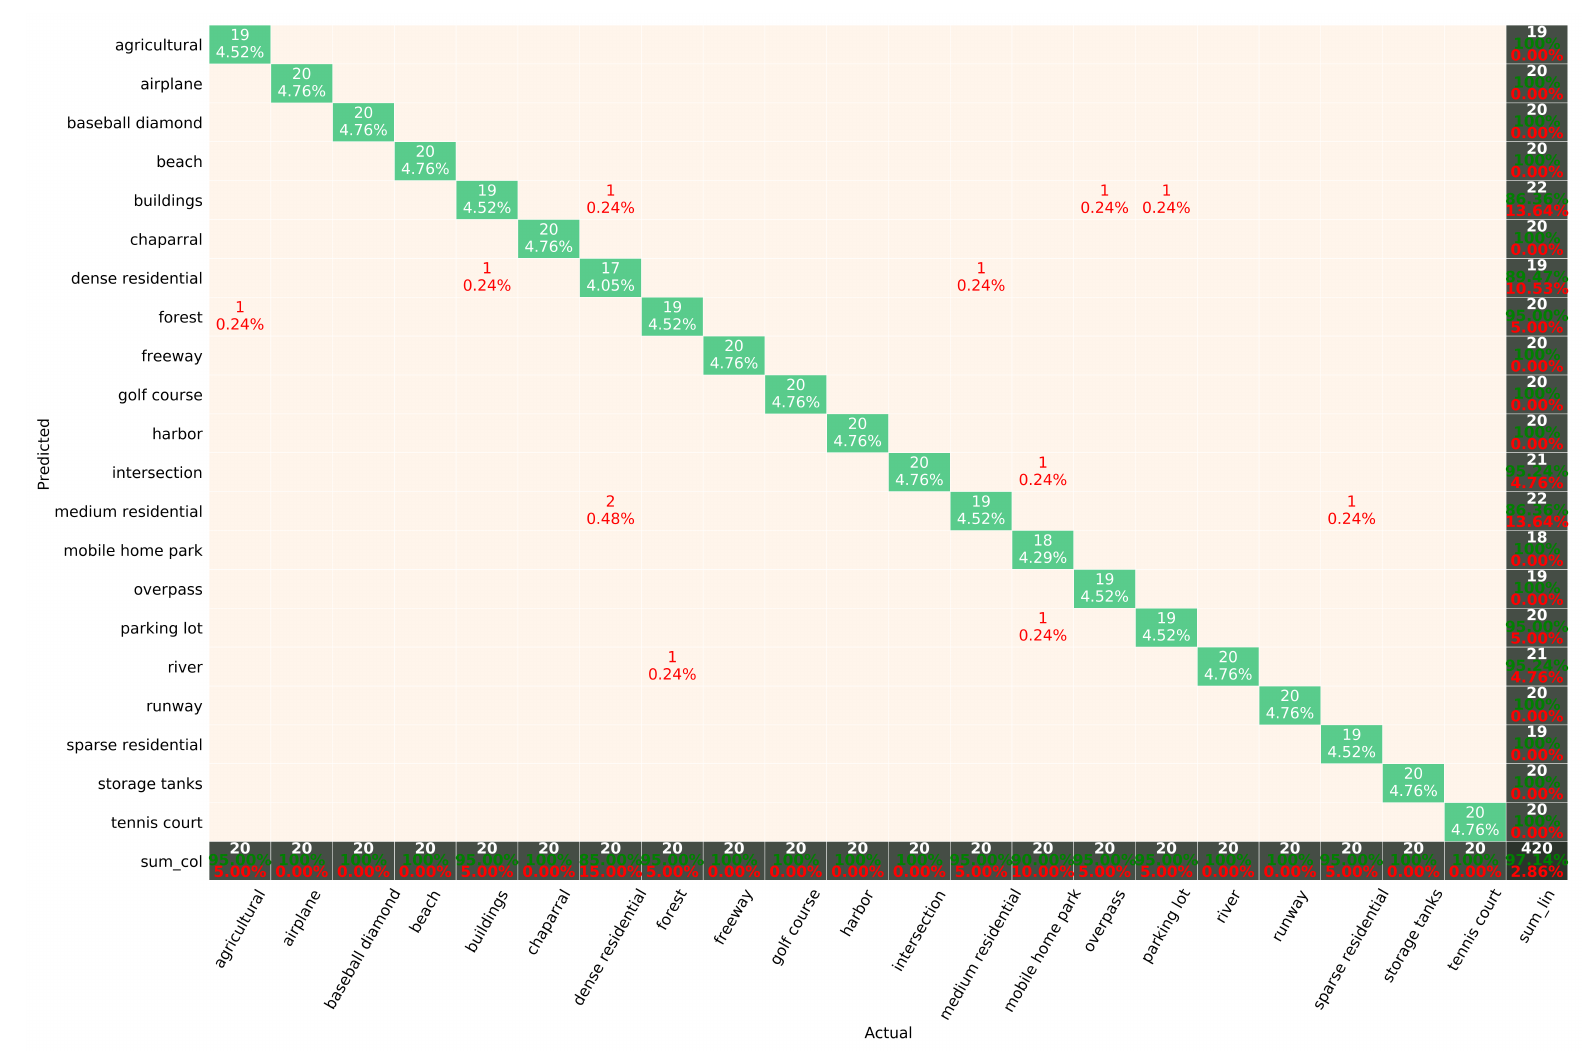
Figure 13. Confusion matrix of VGG-16 on UC_MerceLandUse test